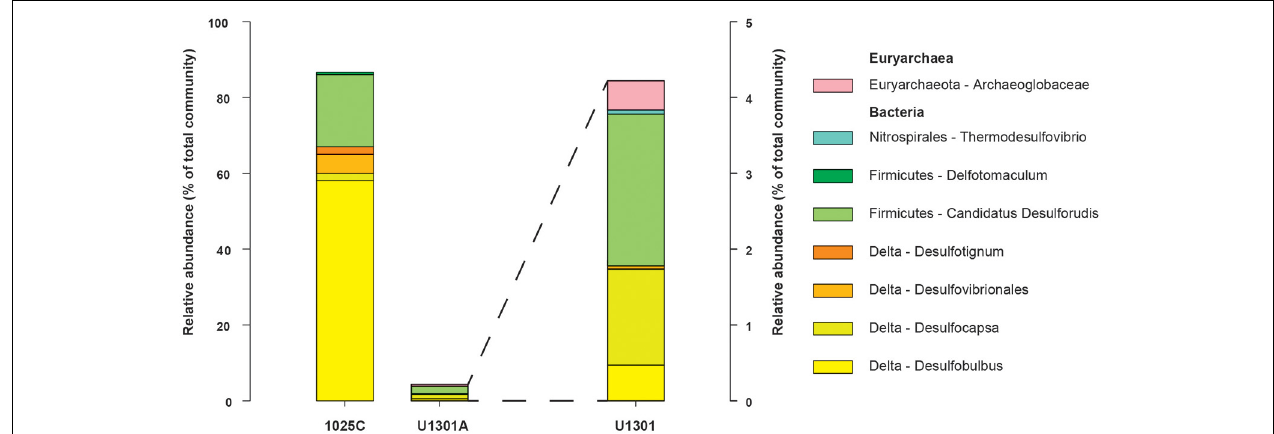
FIGURE 8 | SSU rRNA gene relative abundance from putative SRM recovered from borehole 1025C and U1301A fluids as inferred from close phylogenetic relationships to known